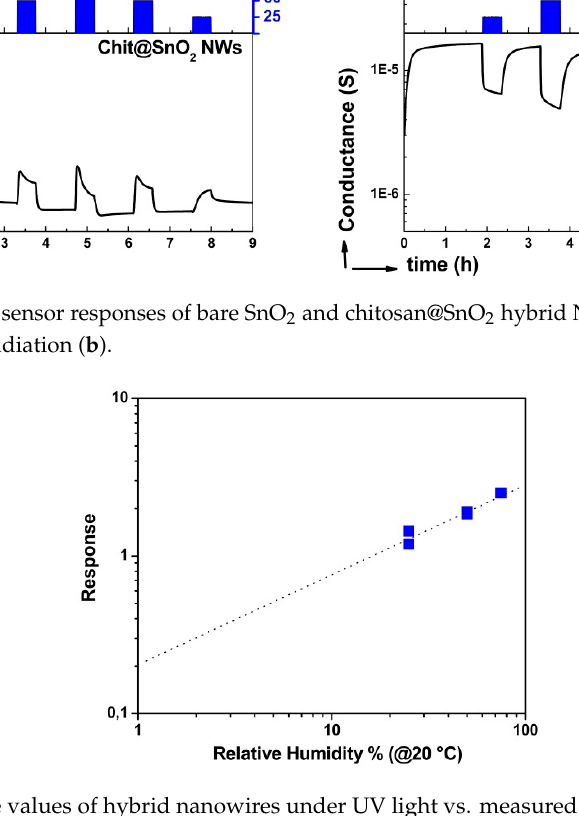
Figure 7. Response values of hybrid nanowires under UV light vs. measured relative humidity (RH) levels in logarithmic scales.